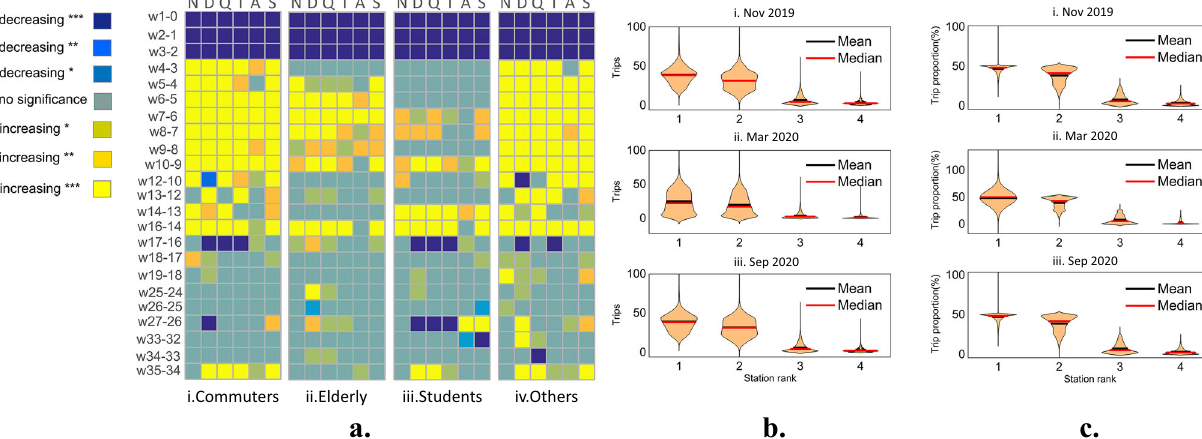
Fig. 4 t test analysis and trip distribution by station rank. a Week-to-week t test of mobility indicators for commuters, elderly, students, and other frequent travelers. For example, w1-0 indicates a t test analysis comparing week 1 (from 19 to 25 January) with week 0 (from 12 to 18 January 2020). Individual trips in continuous 19 weeks between January and May are used. Trips from 1 to 28 July and those from 1 to 28 September are used, and they are weeks 24 – 27 and weeks 32 – 35. N , D , Q , T , A , and S denote variations of subjects who traveled, traveled days, trips, total distance, activity space, and stations visited per week. *** p < 0.001, ** p < 0.01, *0.01 ≤ p < 0.05. b Trips by station rank. c Trip proportions by station rank. b and c are drawn with monthly analysis. For a month, we sort out trips by subjects. At the individual level, we rank stations by trips and calculate/the trip proportion generated at each station. We obtain the Top 4 stations for each subject. b and c show that individual trips usually concentrate on their own top 1 and 2